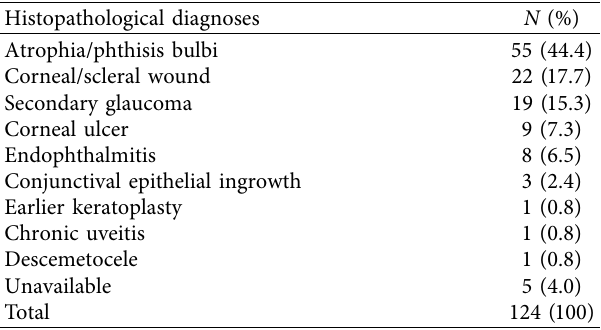
Table 5: Histopathological diagnoses for enucleated/eviscerated eyes due to ocular